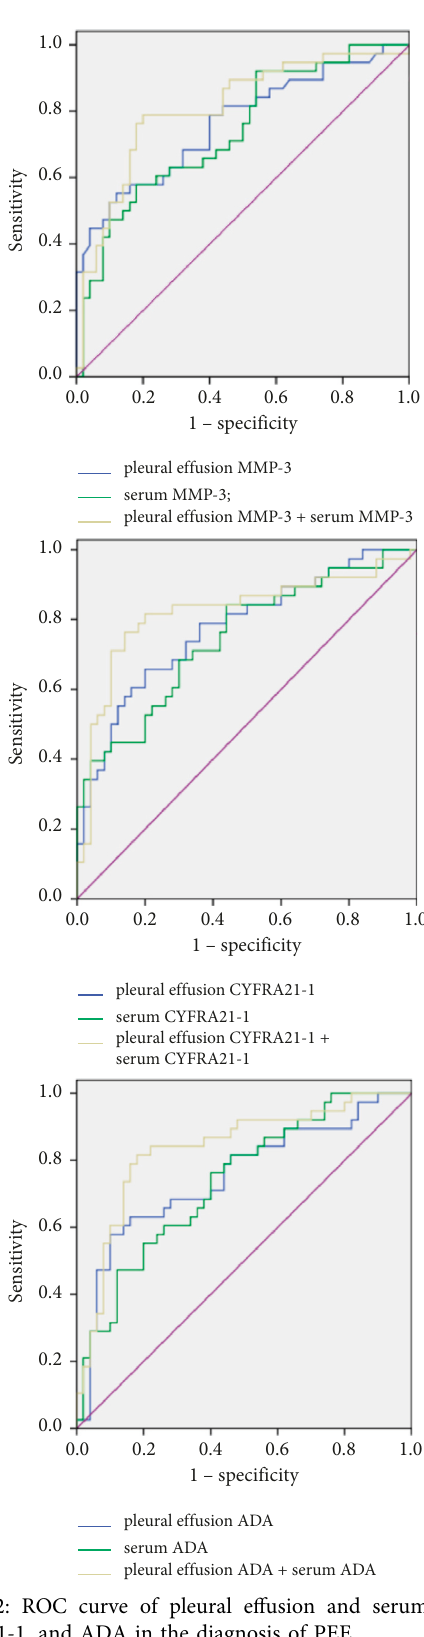
Figure 2: ROC curve of pleural effusion and serum MMP-3, CYFRA21-1, and ADA in the diagnosis of